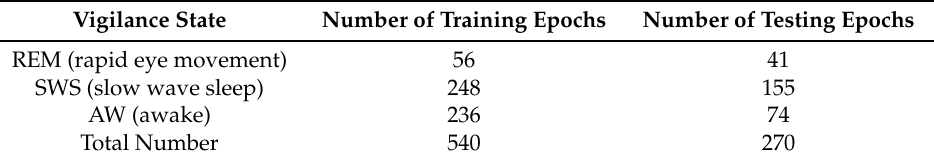
Table 4. Number of epochs in each state.